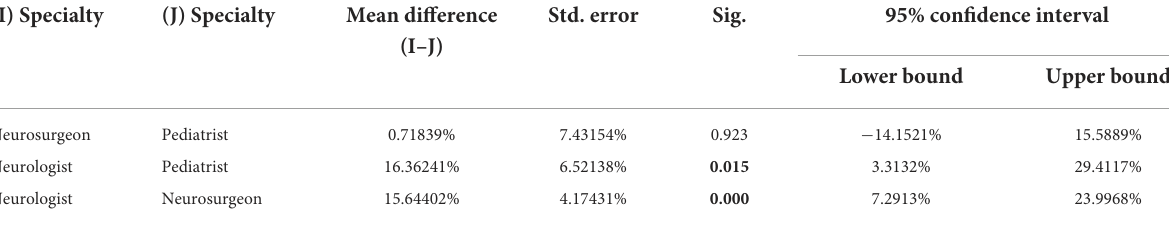
TABLE 5 Multiple comparisons of independent correlates of practitioners’ knowledge.